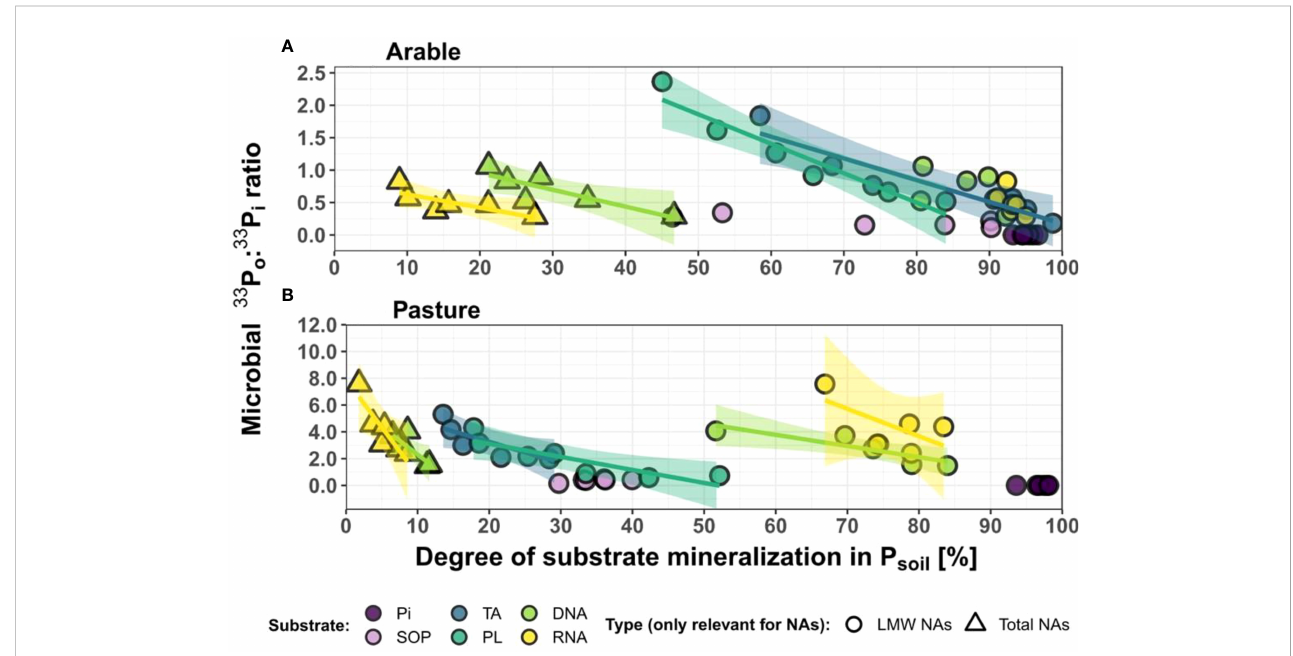
FIGURE 3 Ratios of cumulative P o :P i uptake from labelled substrates decline with progressing substrate mineralization in P soil mineralization in Psoil. , shown for the arable (A) and pasture (B) soil. Data points are the means of triplicates for time points 0.5 to 24 h (the temporal pattern within each treatment proceeds from left to right). For both nucleic acid treatments (DNA, RNA), substrate mineralization is given for for total extractable NAs [high molecular weight (HMW) + low molecular weight (LMW)] and for the LMW fraction only. Fitted signi fi cant models are shown with 95% con fi dence intervals. For